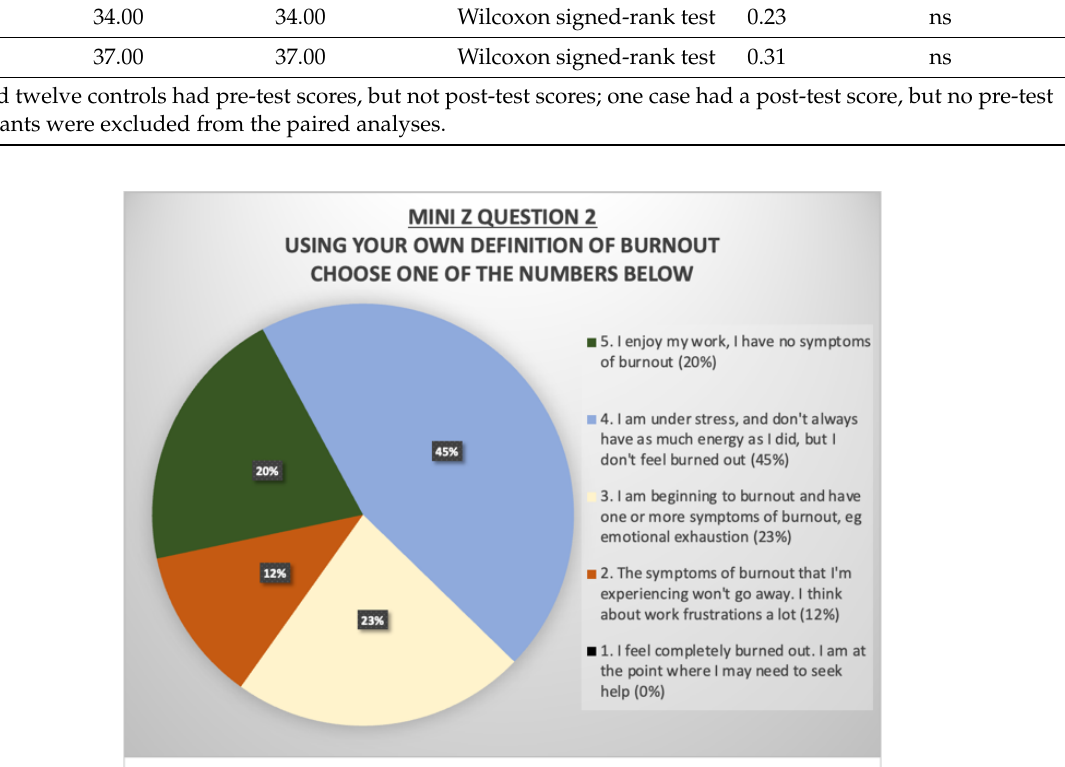
Figure 2. Results from all participants on Mini-Z Question 2 concerning burnout symptoms.